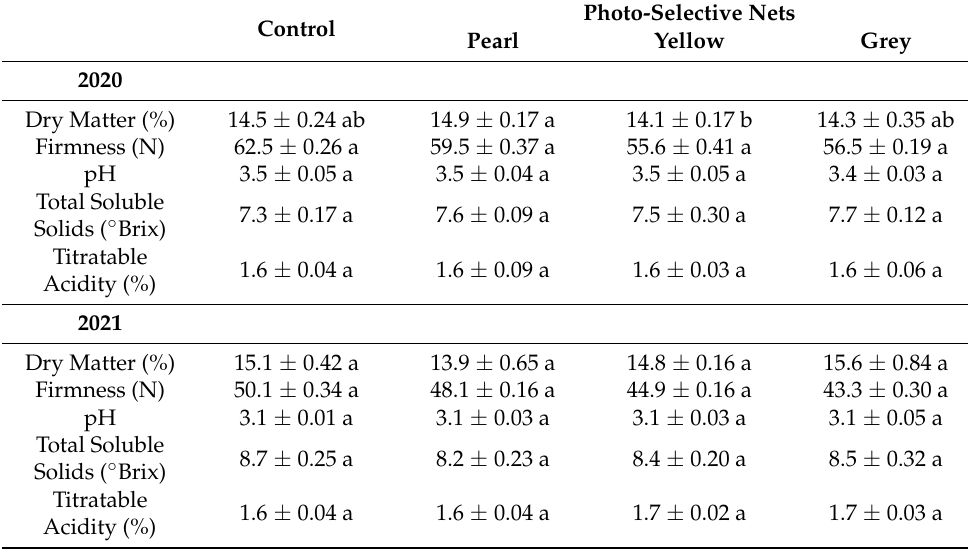
Table 4. Dry matter (%), firmness (N), pH, total soluble solids content ( ◦ Brix) and titratable acidity (%) response (mean ± standard error) to the effect of pearl, yellow and grey photo-selective nets at harvest in 2019 and 2020. For each year, means in the same row followed by different letters are significantly different ( p <